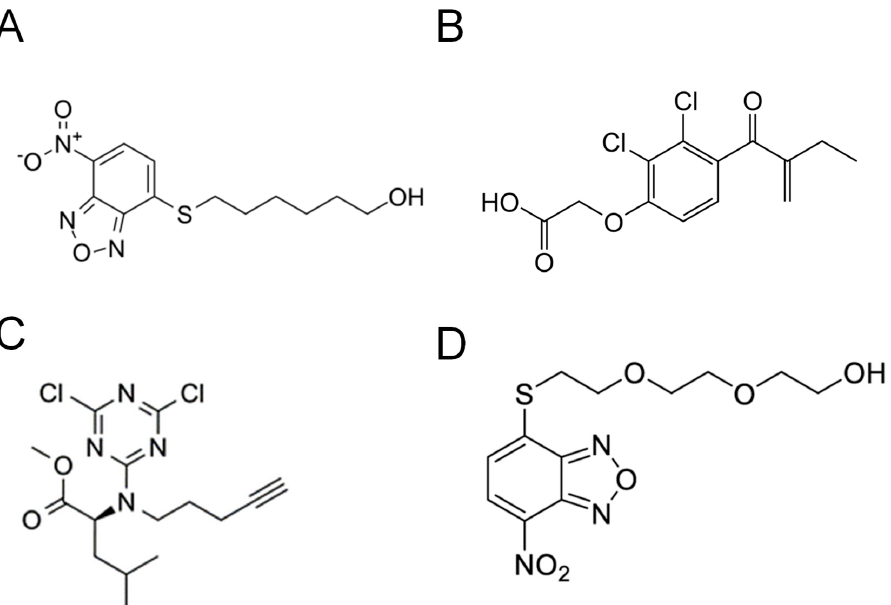
Figure 5. Structure of inhibitors that bind to the G-site of GST proteins. ( A ) 6-(7-nitro-2,1,3-benzoxadiazol-4-ylthio)hexanol (NBDHEX), ( B ) ethacrynic acid, ( C ) LAS17, and ( D ) MC3181 (2-(2-(2-((7-nitrobenzo[c][1,2,5]oxadiazol-4-yl)thio)ethoxy)ethoxy)ethanol), an NBDHEX analogue.